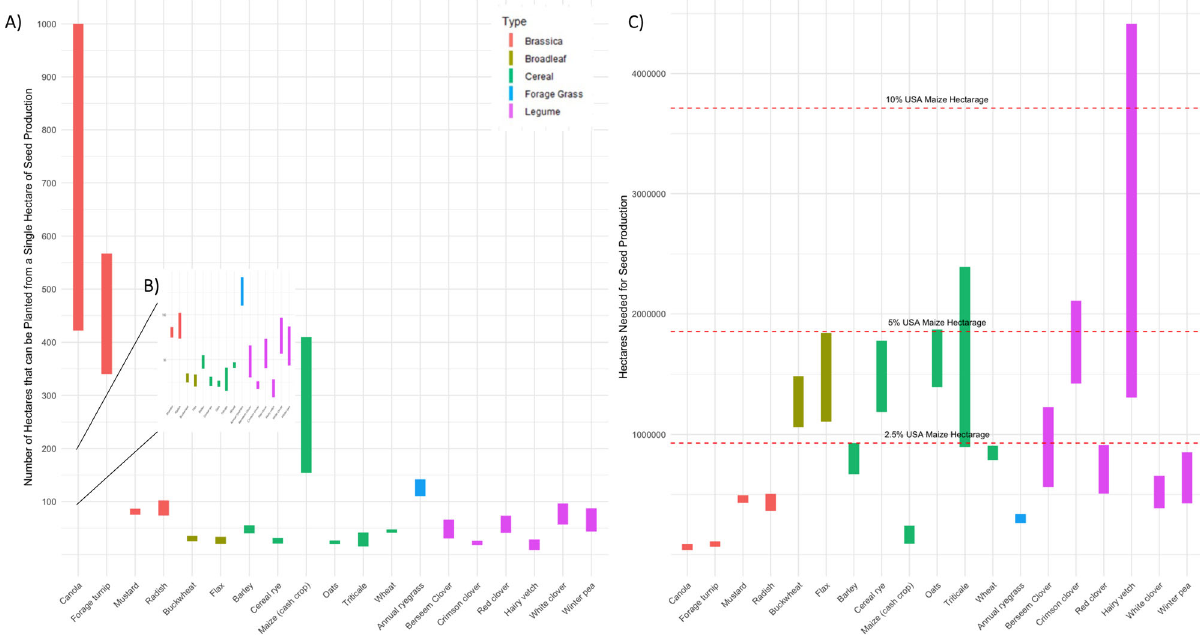
The Abstract stated: “ In this Perspective, we estimate land use requirements to supply the United States maize production area with cover crop seed, fi nding that across 18 cover crops, on average 3.8% (median 2.0%) of current production area would be required, with the popular cover crops rye and hairy vetch requiring as much as 4.5% and 11.9%, respectively ” . The text should read: “ In this Perspective, we estimate land use requirements to supply the United States maize production area with cover crop seed, fi nding that across 18 cover crops, on average 2.4% (median 2.1%) of current production area would be required, with the popular cover crops rye and hairy vetch requiring as much as 4.8% and 11.9%, respectively ” . In the 1 st paragraph of the right hand column on page 2, the text said: “ ( … ), we fi nd that the land requirements for production of cover crop seed would be on average 1.4 million hectares (median 746,000 ha), which is equivalent to 3.8% (median 2.0%) of the U.S. maize farmland. Rye ( Secale cereale L.) – a midrange seed yielding cover crop and one of the most commonly used in the corn belt, would require as much as 1,661,000 hectares (4.5% of maize farmland), ( … ) ” The text should read: “ ( … ) we fi nd that the land requirements for production of cover crop seed would be on average 892,526 hectares (median 774,417 ha), which is equivalent to 2.4% (median 2.1%) of the U.S. maize farmland. Rye ( Secale cereale L.) – a midrange seed yielding cover crop and one of the most commonly used in the corn belt, would require as much as 1,779,770 hectares (4.8% of maize farmland), ( … ) ” On page 3, second paragraph the text said: “ Cover cropping the entire U.S. maize area would require the equivalent of as much as 18% (rye) to 49% (hairy vetch) ( … ) ” The text should read: “ Cover cropping the entire U.S. maize area would require the equivalent of as much as 19% (rye) to 49% (hairy vetch) ( … )